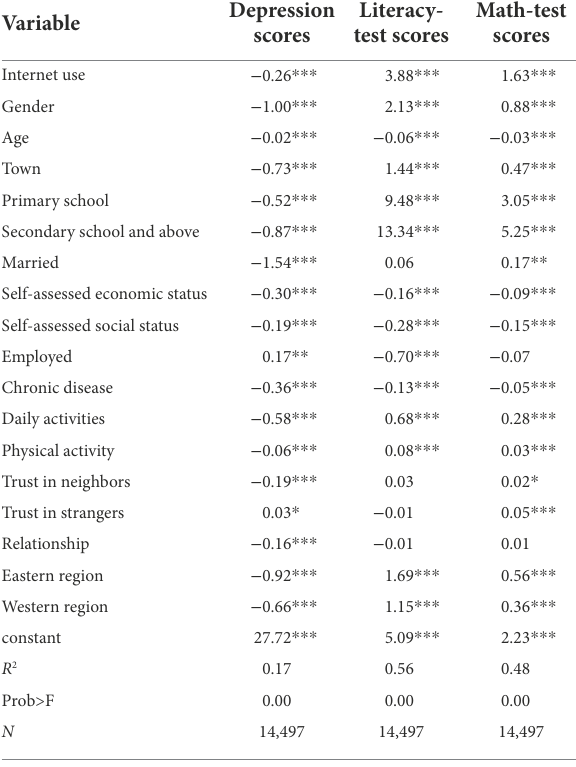
TABLE 2 Relationship between Internet use and mental health. Variable